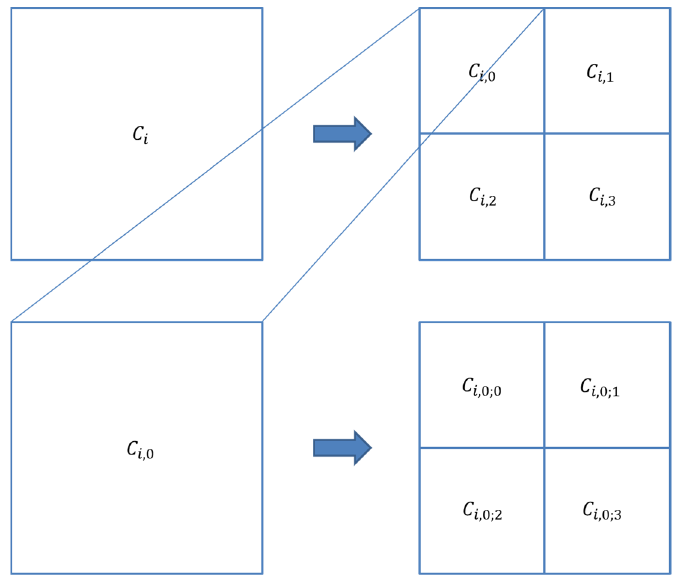
Figure 7. The partition of the “0” depth level and its corresponding sub-CU areas.